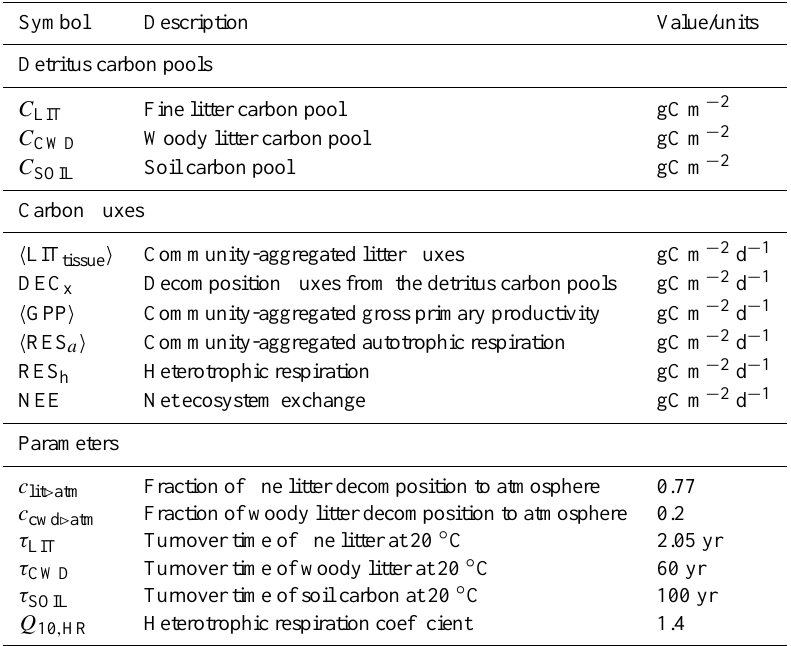
Table C5. State variables, fluxes, and parameters of the soil carbon